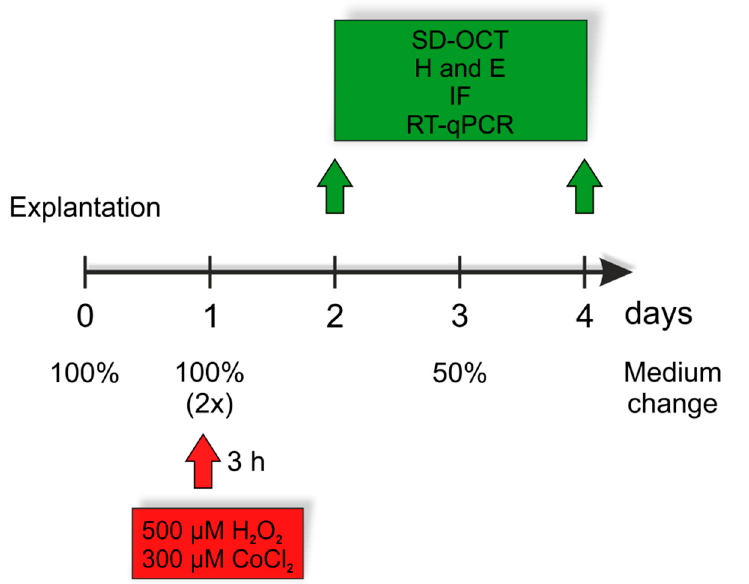
Figure 1. Experimental setup. Porcine retinas were cultivated for two and four days. Degeneration was induced by H 2 O 2 (500 µ M) or CoCl 2 (300 µ M) at day one for three hours. Control retinas were cultivated without a stressor. Each group received a complete medium change on days zero and one. Half of the medium was renewed on day three. On day two and four, spectral domain-optical coherence tomography (SD-OCT), hematoxylin and eosin staining (H & E), and immunofluorescence (IF) as well as quantitative real-time PCR (RT-qPCR) analyses were